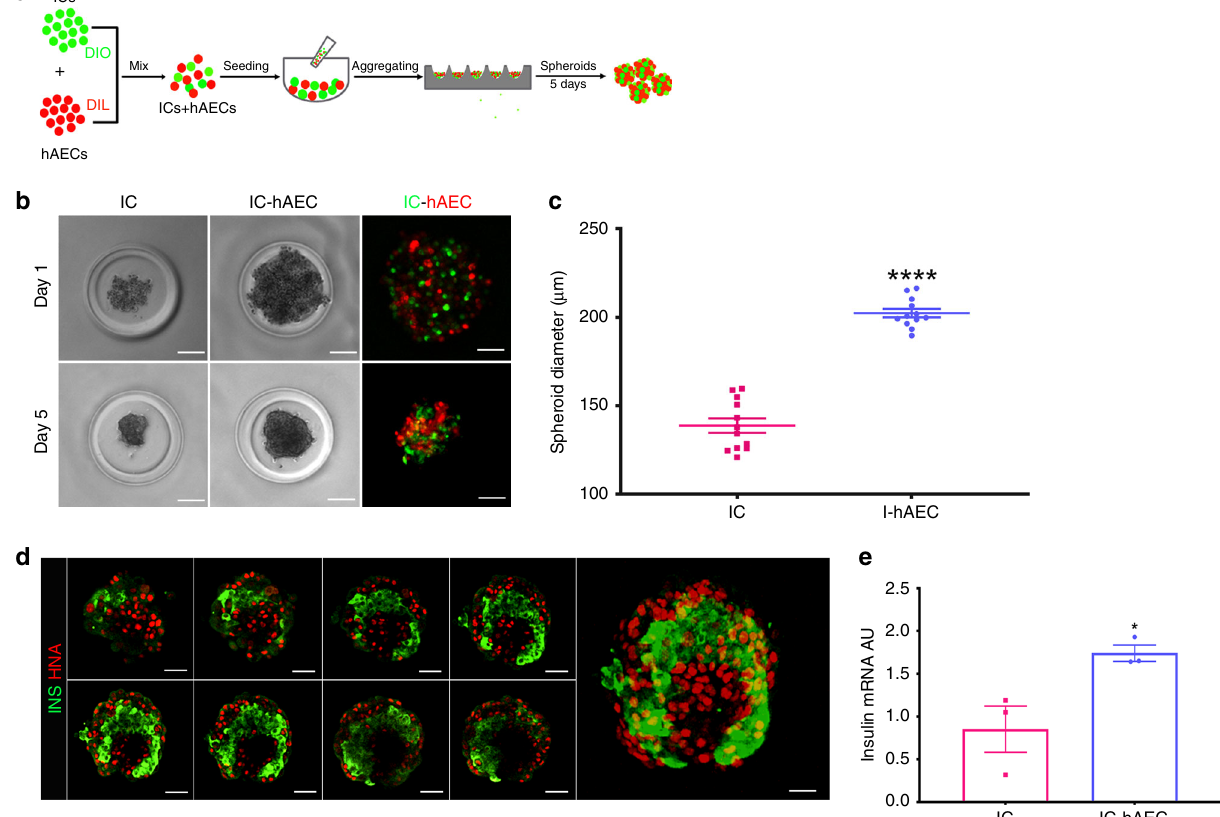
Fig. 2 In vitro characterization of islet organoids. a Schematic representation of islet organoid engineering. After labeling with Dio and DiI, ICs and hAECs were mixed, seeded and incubated several days on 3D agarose-patterned microwells to generate islet organoids. b Phase-contrast and corresponding fl uorescence views of spheroids in one microwell on days 1 and 5. After 5 day culture (bottom), cells undergo compaction and spheroids appear to acquire a smooth border as compared with aggregated cells at day 1. Scale bar = 50 μ m. c Diameters of IC spheroids and IC-hAEC organoids ( n = 12). **** p > 0.0001, unpaired Student ’ s t test. d Confocal views of islet-cell construct. Cell arrangement and composition of the islet organoid on day 14. Islet-derived cells stained for Insulin (green) and hAECs for human nuclear factor (red). Every ninth section of a z -stacked and the entire 3-D reconstructed islet heterospheroid (right panel) are shown. Scale bar = 50 μ m. e Insulin mRNA expressed by IC spheroids and IC + hAEC organoids; insulin mRNA was analyzed by qPCR, arbitrary units (AU) after normalization to housekeeping genes. * p < 0.04, unpaired Student ’ s t test, n = 3. All data shown are mean±